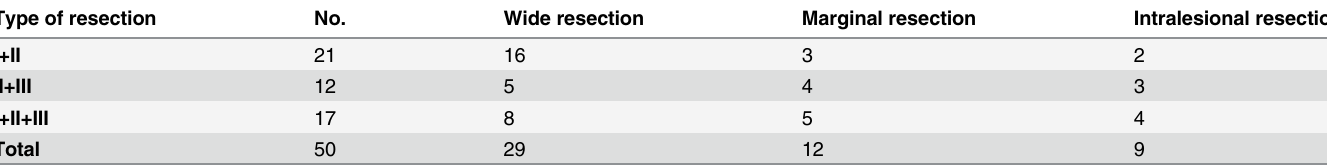
Table 2. Types of resection and surgical